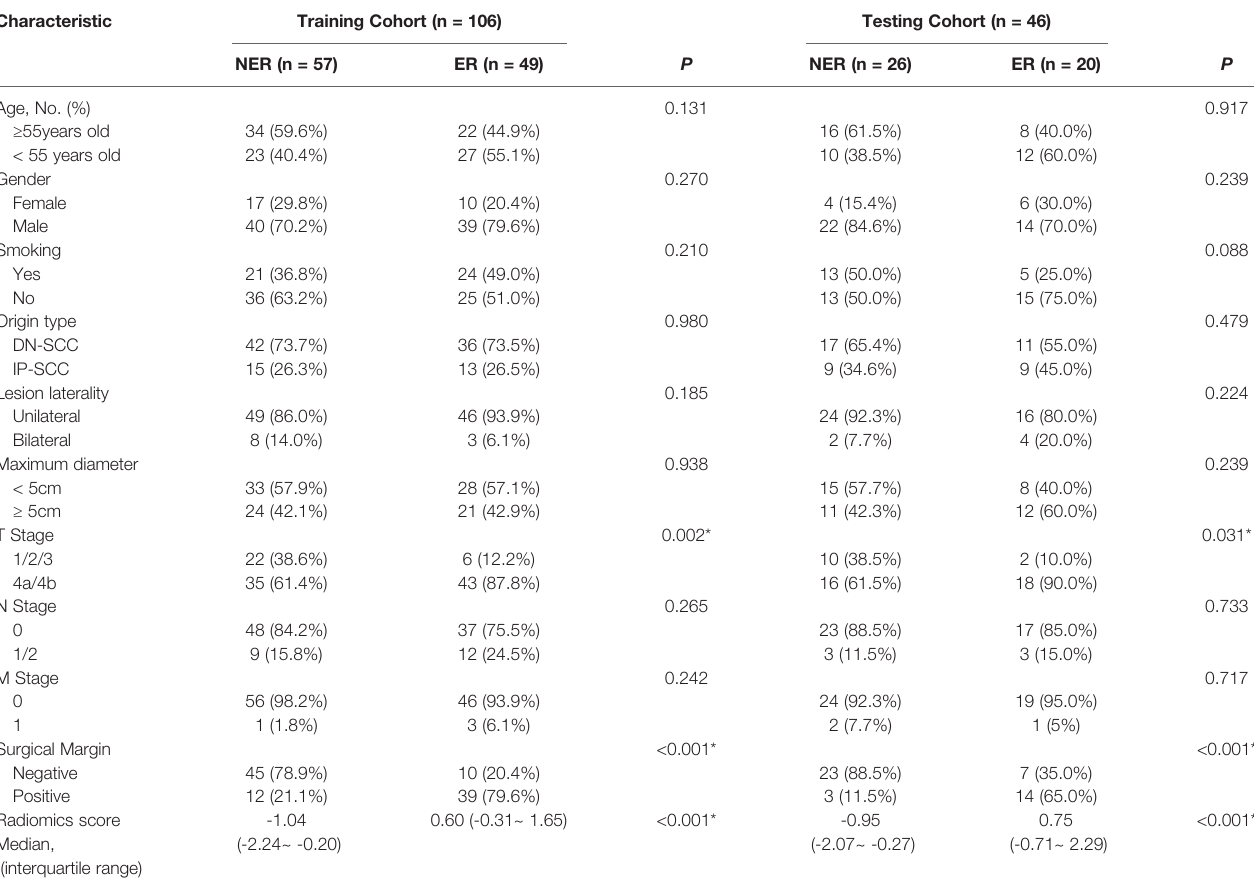
TABLE 1 | Characteristics of patients in the training and testing cohorts.